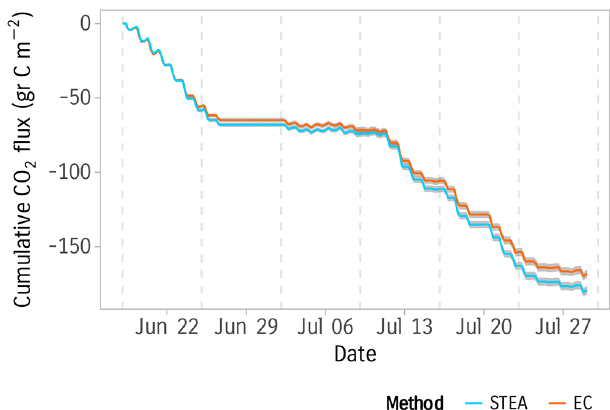
Figure 9. Cumulative fluxes of STEA and EC during the experi- mental period from 18 June to 31 July 2020. Bands represent the flux random error (2 σ ) estimated from the random sampling error of the EC fluxes. Only data with good quality were used, and no gap filling was